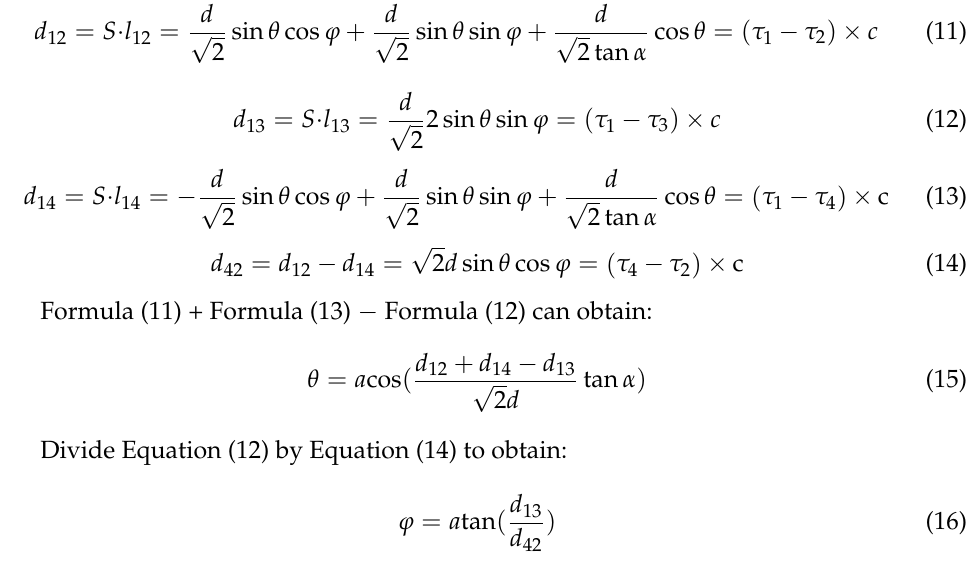
. Here, the red dot indicates the location of the source.